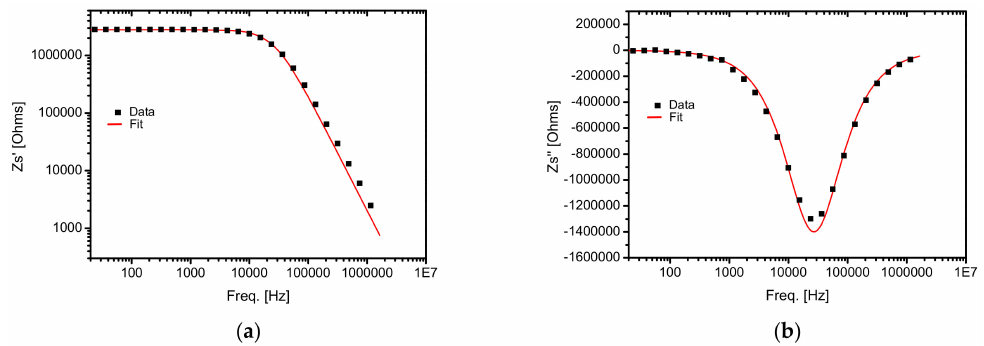
Figure 4. ( a ) Real part of impedance, Z (cid:48) , versus the frequency (f) at U DC = 10 V, t = 6.000 s, without light; ( b ) imaginary part of impedance, Z (cid:48)(cid:48) , versus the frequency (f) at U DC = 10 V, t = 6.000 s, without light.